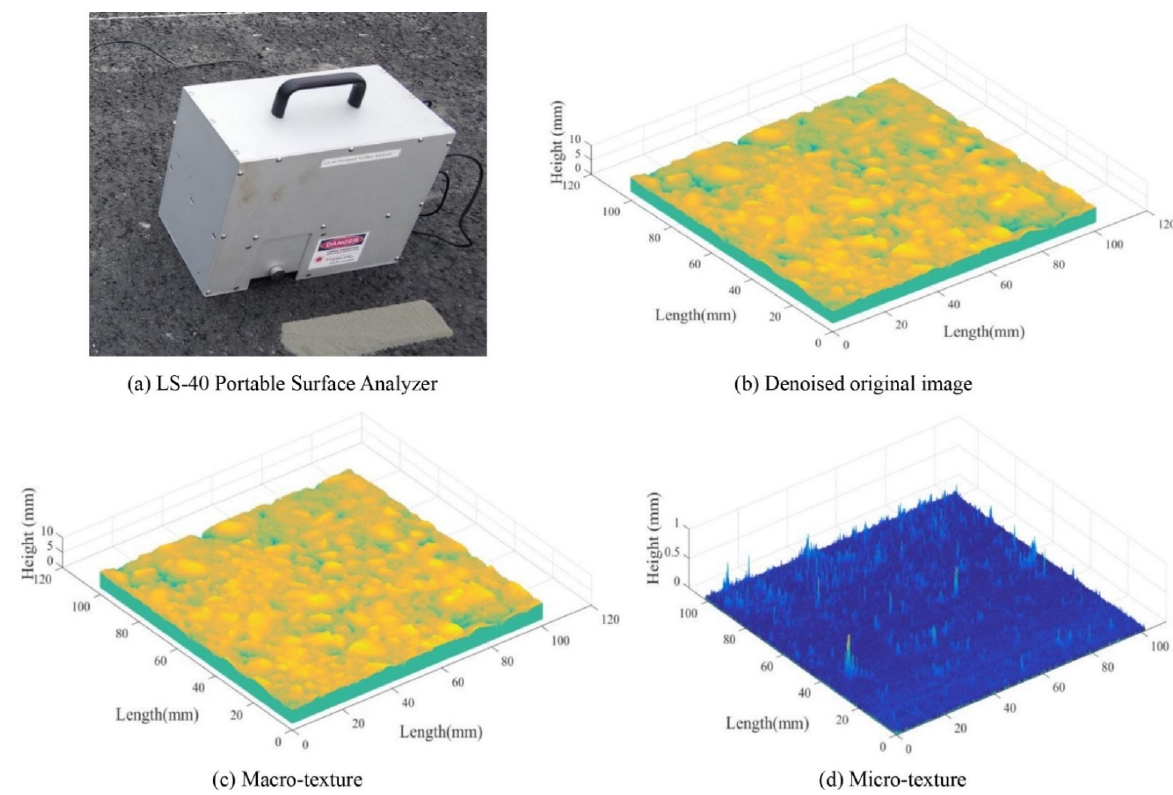
Figure 2. LS-40 and examples 3D texture data: ( a ) LS-40 Portable Surface Analyzer, ( b ) Denoised original image, ( c ) Macro- texture, and ( d ) Micro-texture.